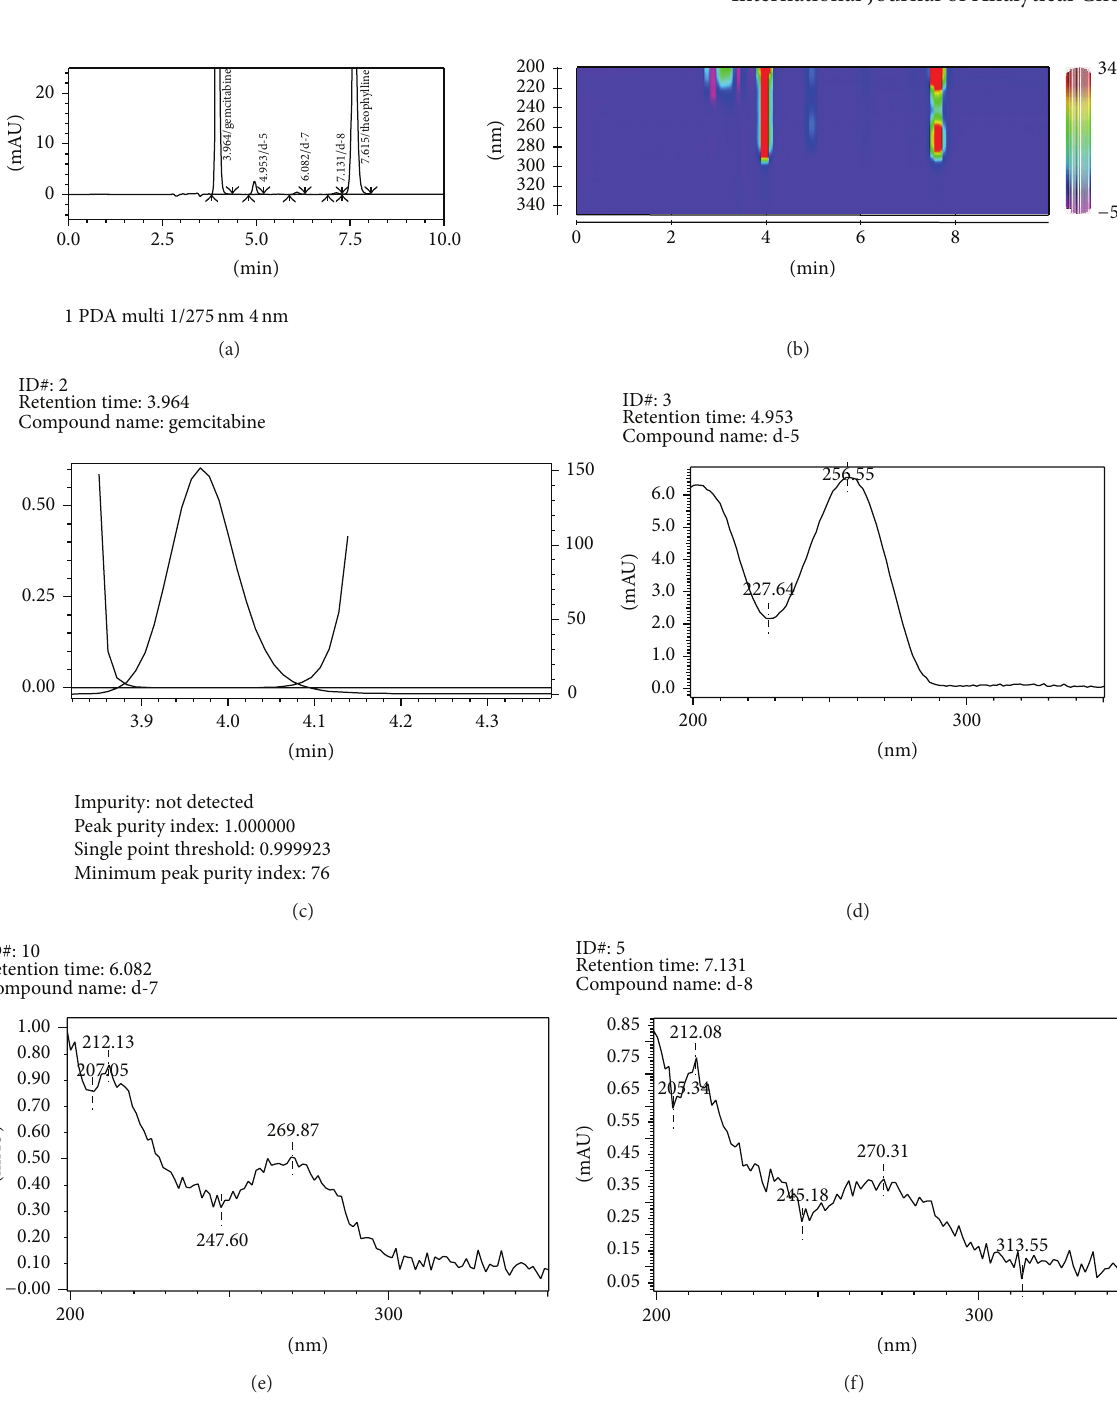
Figure 6: Typical HPLC chromatogram of (a) gemcitabine exposed to acidic stress (1N HCl, 60 ∘ C, 1h), (b) contour plot, (c) peak purity index, and extracted UV spectrum of (d) degraded product d-5, (e) d-7, and (f)